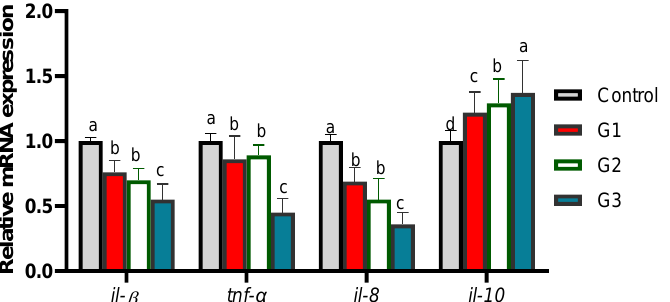
Figure 2. Transcriptional levels of cytokines’ genes [Interleukin ( il )- β , il-8 , il-10 , and tumor necrosis factor- α ( tnf- α )] in fish fed diets fortified with Thy and/or ThQ. Results are expressed as means ± SEM. Columns with various letters represent significant variations ( p < 0.05). Control: tilapia fed basal diets without any supplementations, G1: tilapia fed basal diets with thymol (Thy) supplementation at a concentration of 200 mg/kg diet, G2: tilapia fed basal diets with thymoquinone (ThQ) supplementation at a concentration of 200 mg/kg diet, and G3: tilapia fed basal diets with Thy/ThQ supplementation at a concentration of 200 mg/kg, diet each.